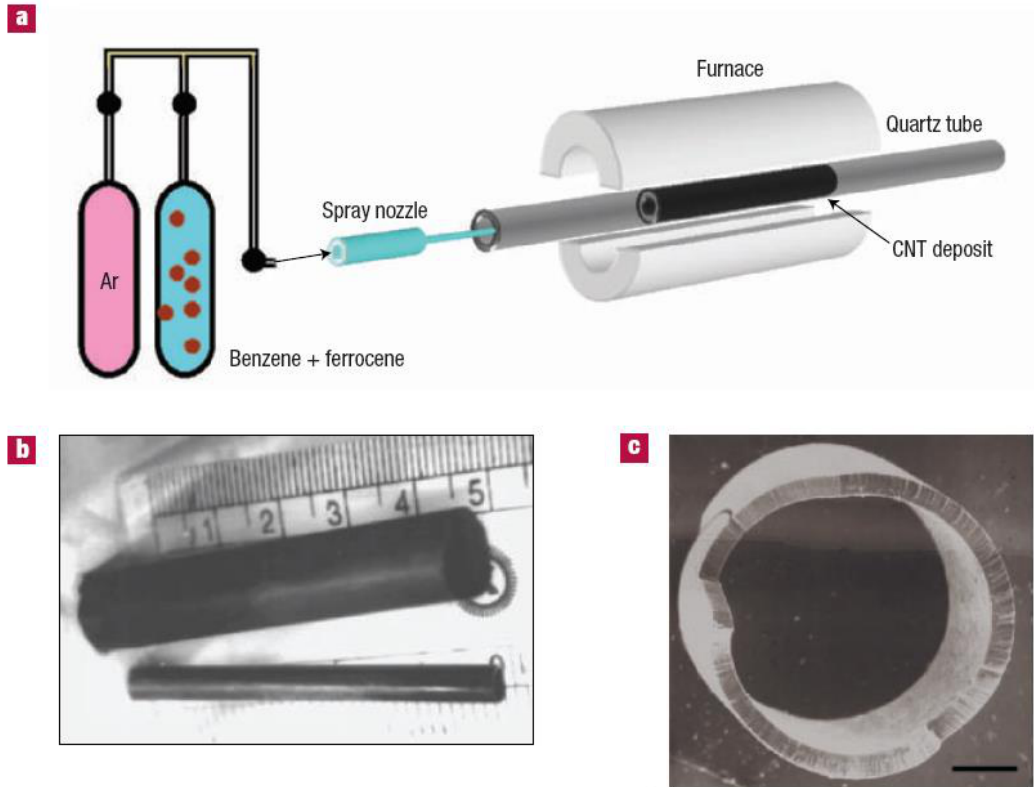
Figure 3 – Production of the macro architecture of aligned nanotubes for use in filtration applications. (a) Schematic of the spray pyrolysis set for growing aligned MWNTs. (b) Photograph of the bulk tube. (c) SEM image of the aligned tubes with radial symmetry resulting in hollow cylindrical structure (scale bar 1 mm) (Srivastava et al.,